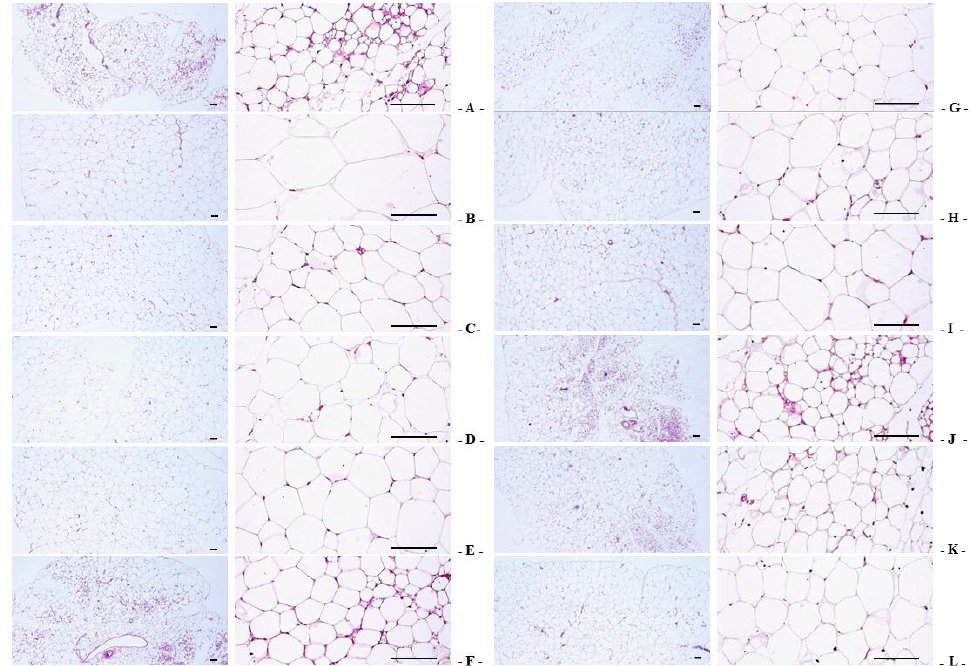
Figure 2. Representative histological images of the adipocytes, taken from sham-operated or OVX